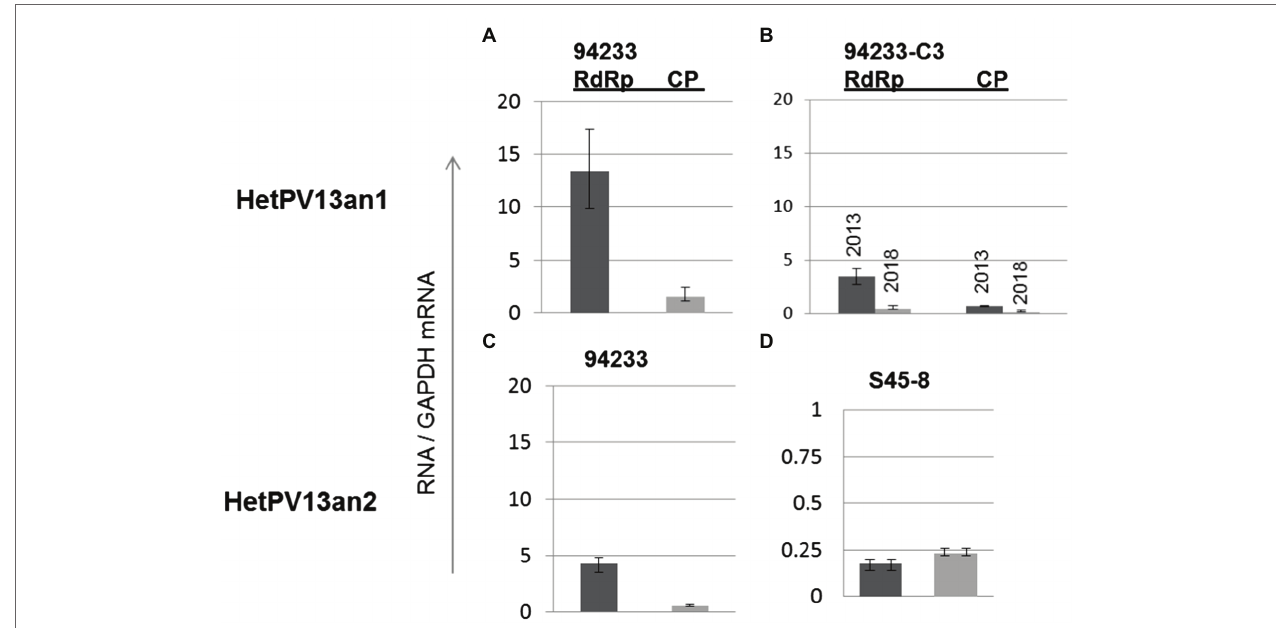
FIGURE 4 | The variation in viral CP and RdRp transcript levels in H. annosum strains infected by partitiviruses. (A) Strain 94233 with its natural viral infection HetPV13-an1, (B) fast-growing sector isolate 94233-RC3 with infection by HetPV13-an1 before (2013) and after storage (2018), and (C,D) the amounts of viral transcripts of HetPV13-an2 in 94233/32D and in its native host (S45-8). Note: The scale for mRNA transcript levels is different in D due to significantly lower levels of expression.